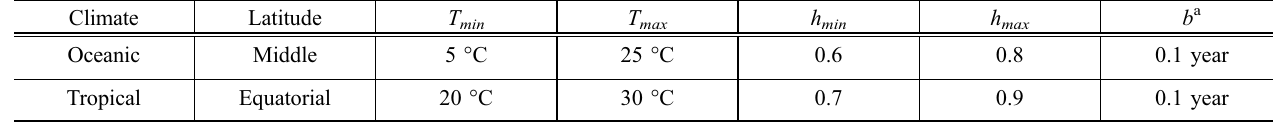
Table 4 Description of the studied environments.